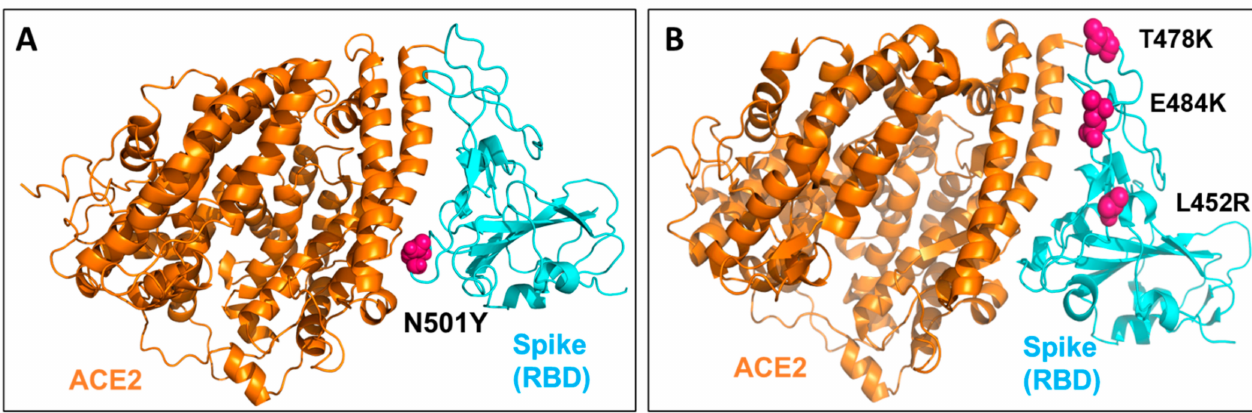
Figure 1. The structure of the receptor binding domain (RBD) of SARS-CoV-2 spike protein complexed with human angiotensin converting enzyme 2 (hACE2) receptor. ( A ) The sphere shape residues in hot pink colour show N501Y mutation in the spike protein of SARS-CoV-2. ( B ) At L452R, T478K and E484Q mutations in the spike protein (RBD) of B.1.617